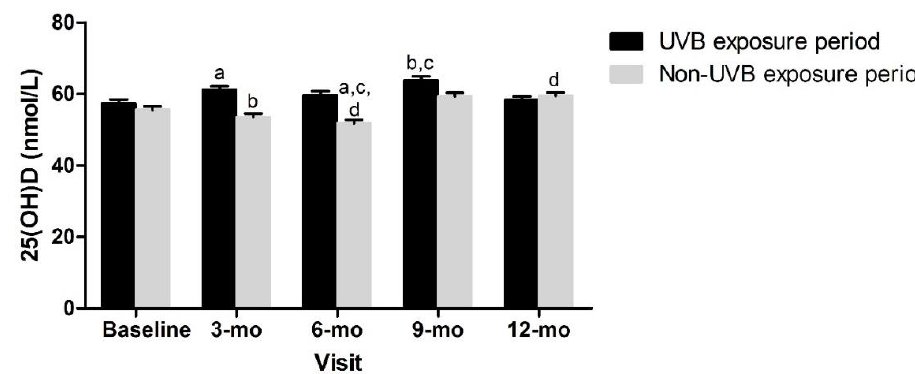
Figure 4. Vitamin D status over time and according to UVB period. Mixed effects model, mean ± SEM. Covariates included sex, age, constitutive skin color, sunscreen use, dietary vitamin D intake. Measures with same superscripts are significantly different from each other; p < 0.05. Table 3. Plasma 25(OH)D between baseline and 12 mo by category of change in adiposity